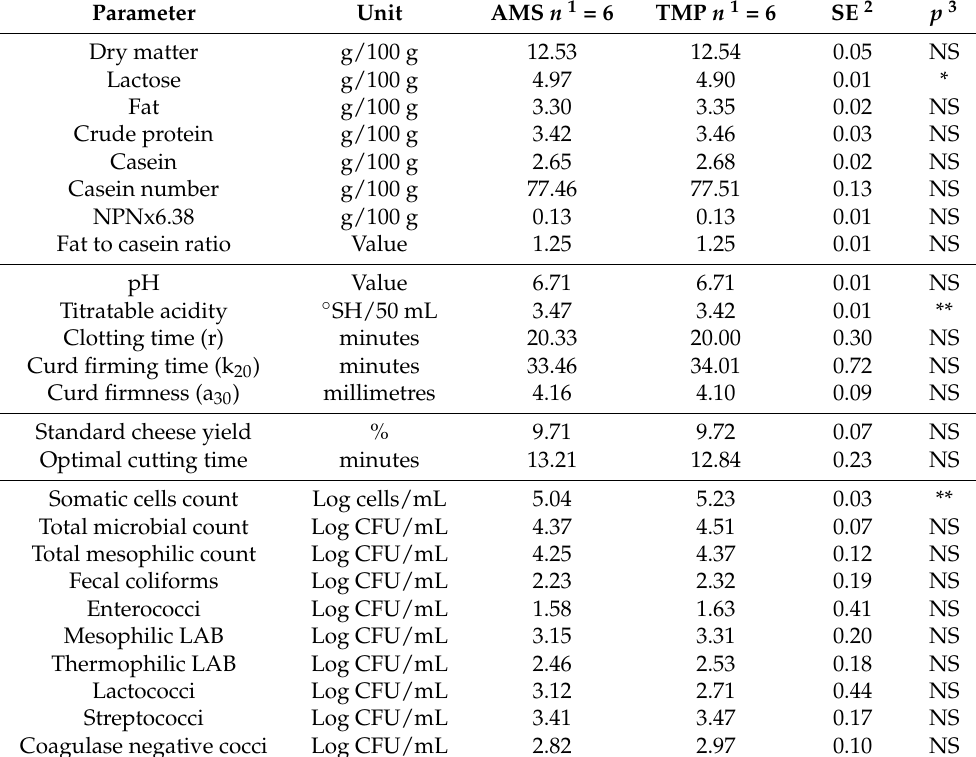
Table 4. Least square means of chemical composition parameters, rennet coagulation properties and microbial counts of vat milk obtained from herd milk milked with an automatic milking system (AMS) and with a traditional milking parlor